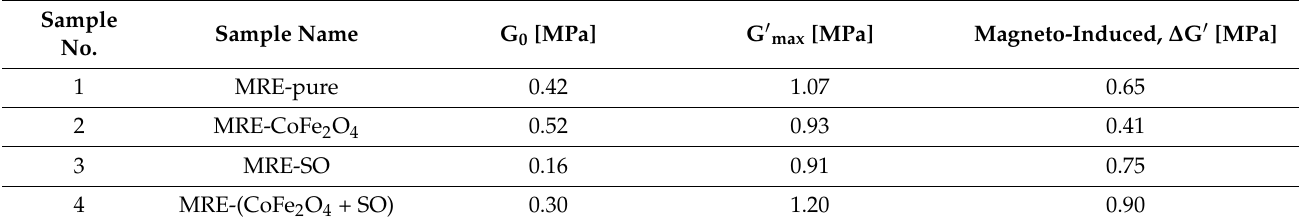
Table 4. The rheological properties of MRE samples under the current